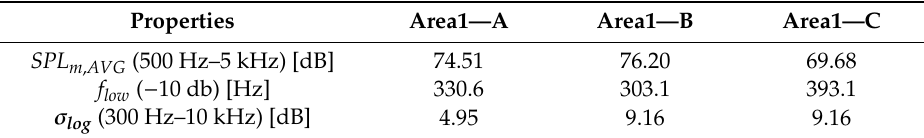
Table 1. Evaluation of the following properties mean SPL, lower frequency limit and the logarithmic standard deviation of all three specifications